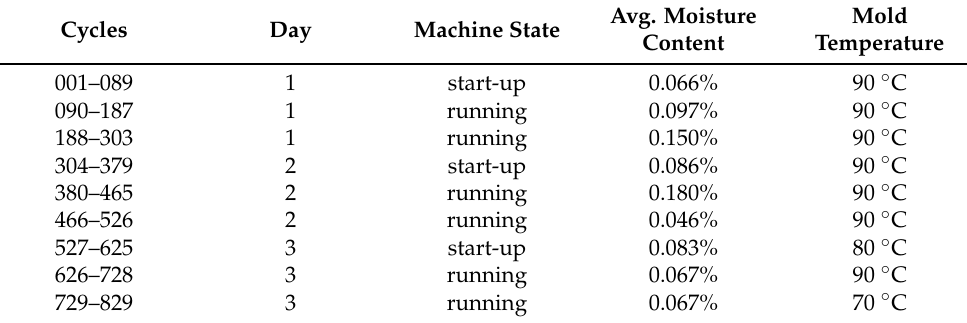
Table 2. Varied parameters for Stacking Box Data Set I.